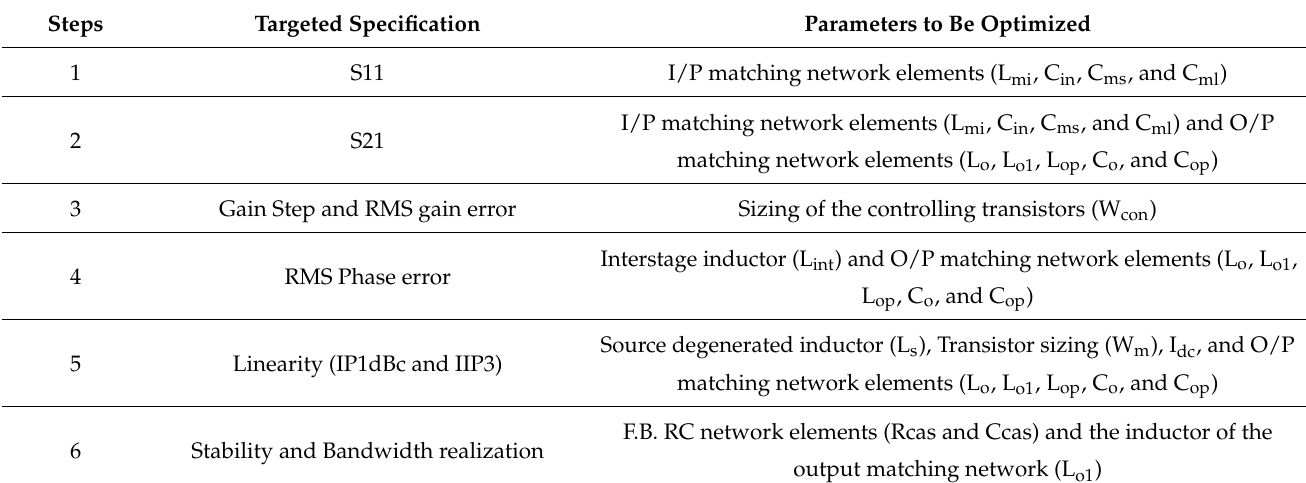
Table 2. The optimizer different stages with the corresponding parameters to be optimized for the required specification.